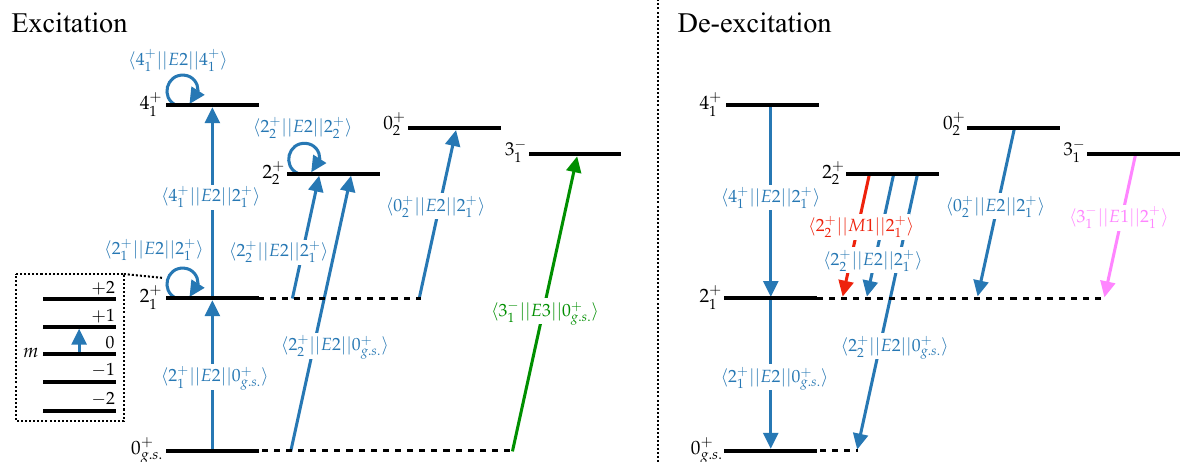
Figure 1. Low-lying level scheme of a fictitious even–even nucleus outlining dominant excitation ( left ) and de-excitation ( right ) patterns in low-energy Coulomb excitation. The transitions are labelled with the corresponding matrix elements. The inset on the left depicts the magnetic substates m of the 2 + state and illustrates the reorientation effect. Some allowed 1 transitions are neglected for